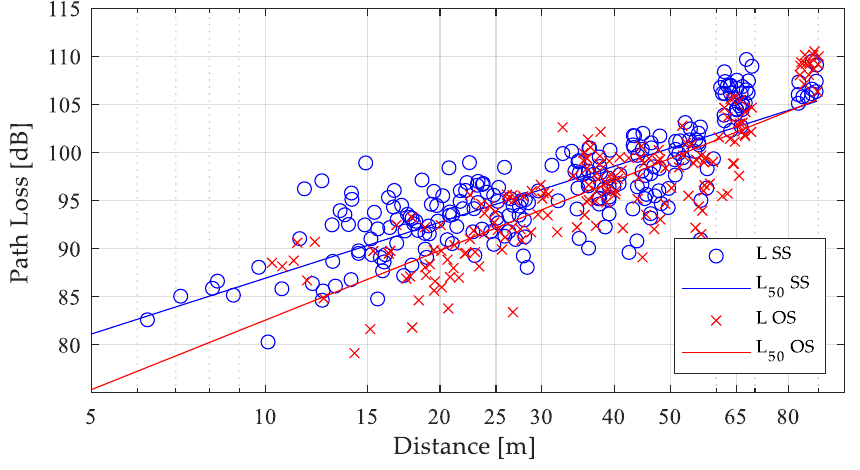
Figure 5. O2I path loss measurements.